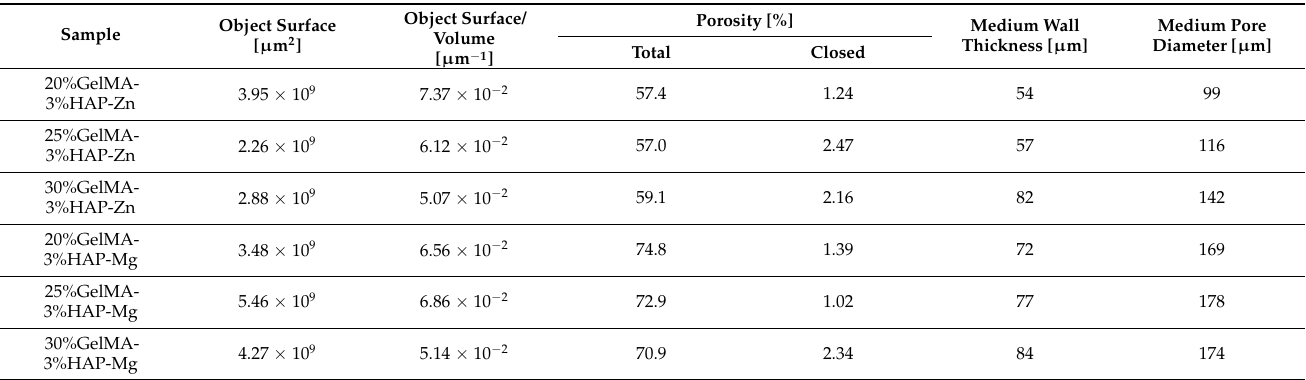
Table 3. Quantitative traits of the GelMA-3%HAP-Zn and GelMA-3%HAP-Mg batches in 3D- printed